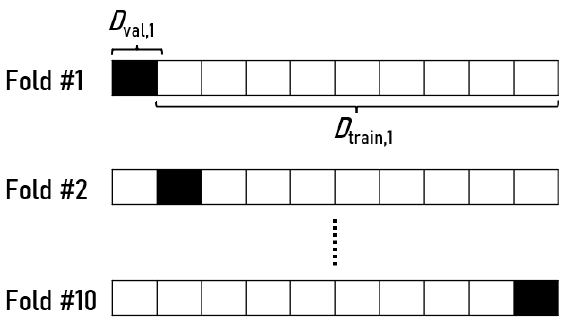
Figure 4. A 10-fold cross-validation example.